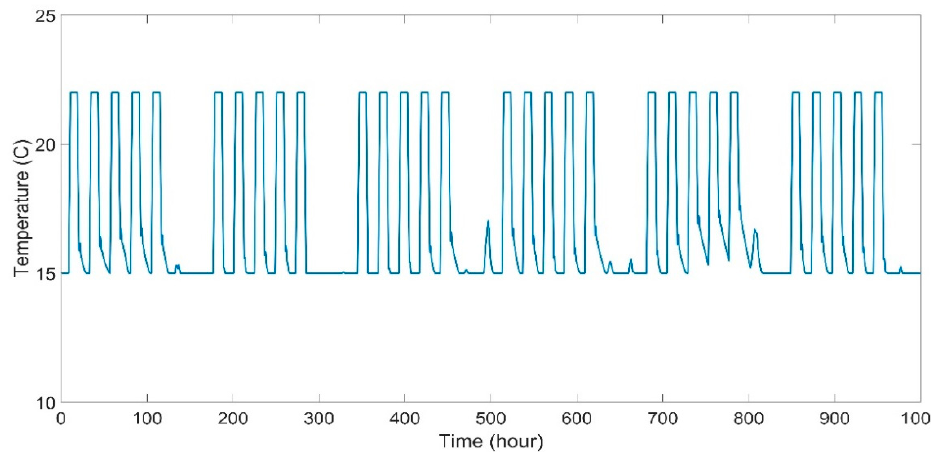
Figure 3. Indoor temperature for a 100 m 2 building simulated in TRNSYS.